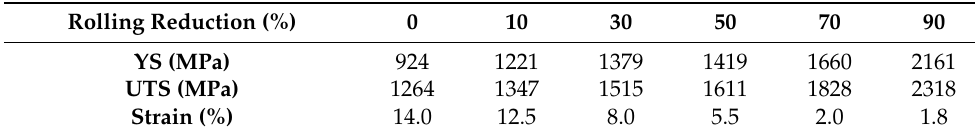
Figure 2. Tensile stress-strain curves of the SK85 steel at different rolling reductions. Table 2. Mechanical properties of the SK85 steel at different rolling